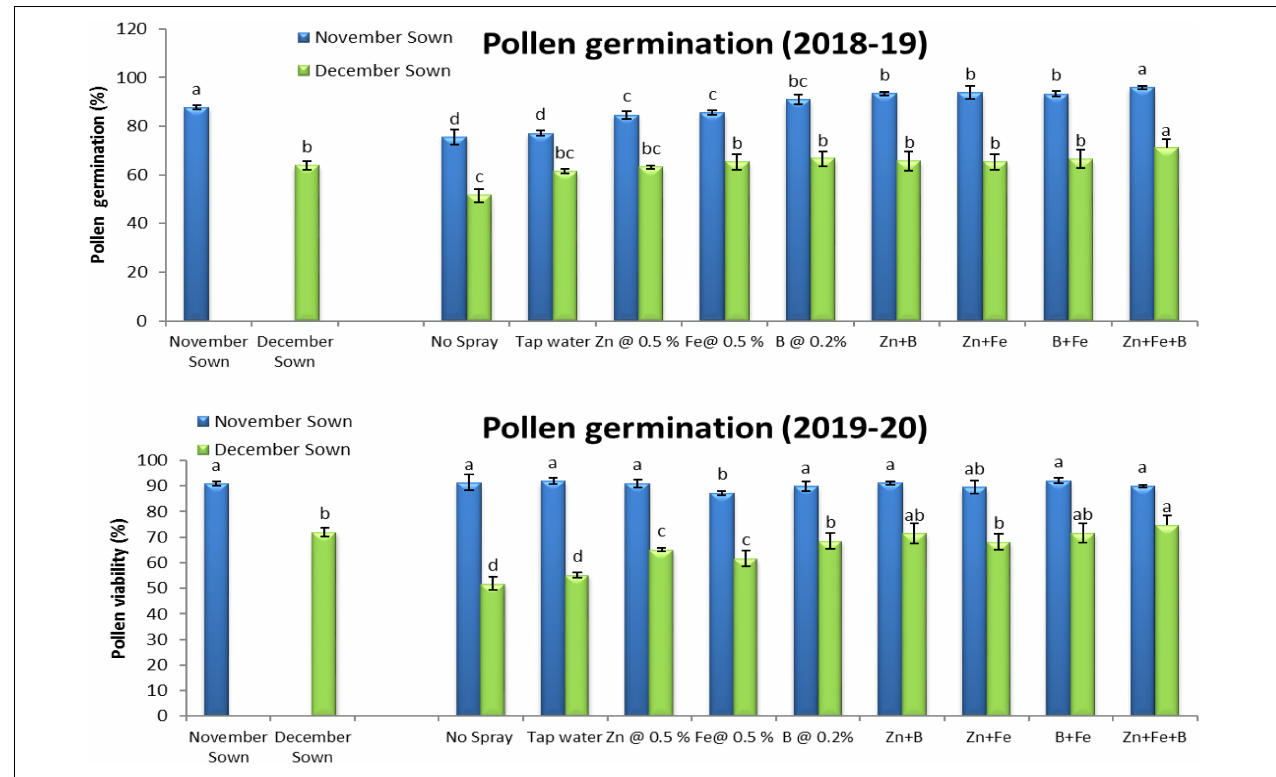
FIGURE 4 | Pollen germination (%) for different sowing dates and foliar spray treatments in the 2018–19 and 2019–20 lentil cropping seasons. Values are means, and bars represent ± SEM ( n = 3). Different letters indicate significant differences between means. TABLE 3 | Effect of sowing time and zinc, iron, and boron foliar sprays on seed growth rate and seed filling duration of lentil.